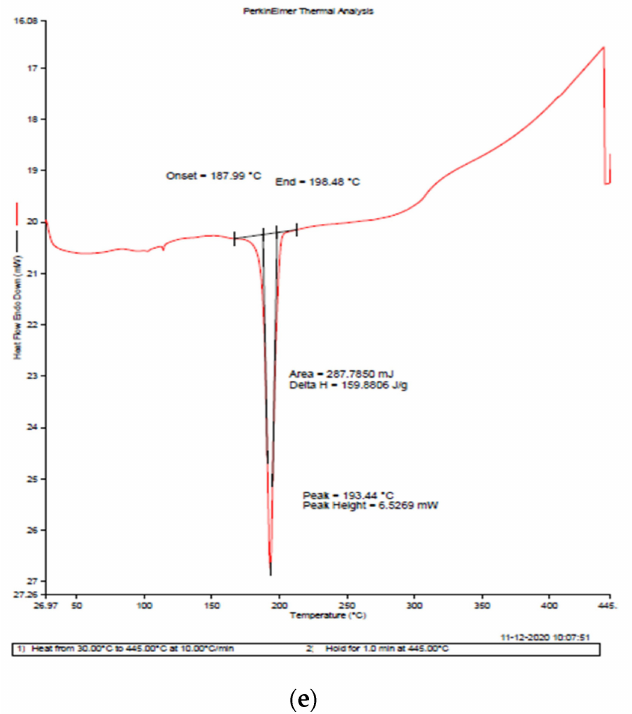
Figure 3. DSC thermograms of raw biopolymeric materials, ( a ) chitosan, ( b ) gum acacia and test samples, ( c ) CSGA blank, NPs ( d ) CSGA-1.0 NPs, ( e ) mancozeb.